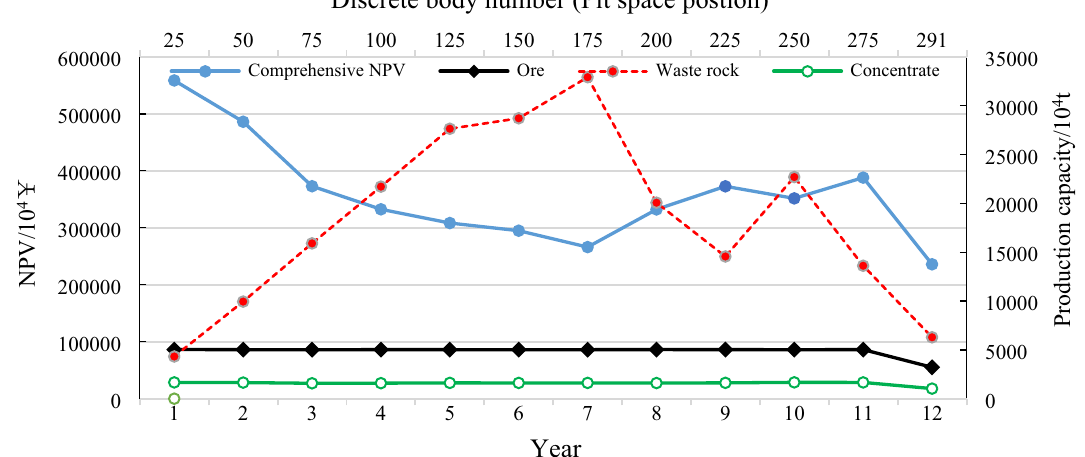
Figure 9. NPV maximum production scheduling without infrastructure investment.